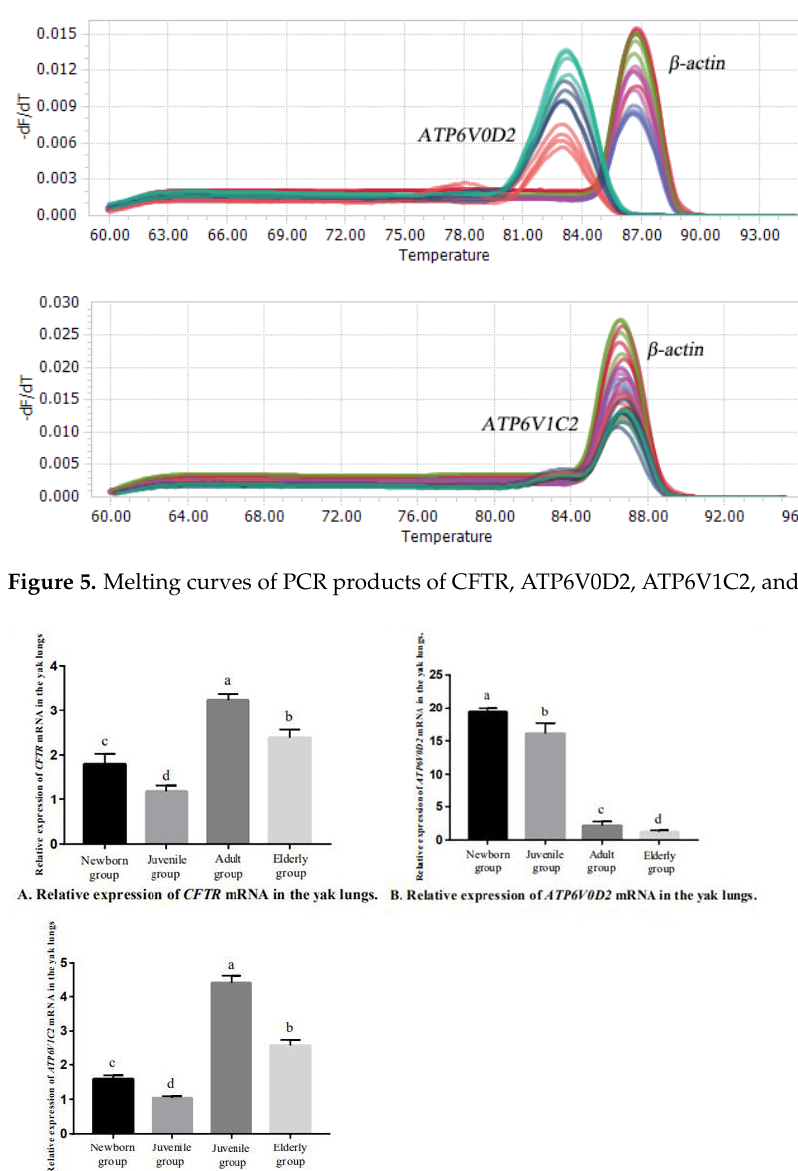
Figure 6. Relative expression of CFTR, ATP6V0D2, and ATP6V1C2 mRNA in yak lungs at different ages. A. Relative expression of CFTR mRNA in the yak lungs. B. Relative expression of ATP6V0D2 mRNA in the yak lungs. C. Relative expression of ATP6V1C2 mRNA in the yak lungs. Note: Different lowercase letters indicate significant differences ( p < 0.05), and the same letters indicate non-significant differences ( p > 0.05).